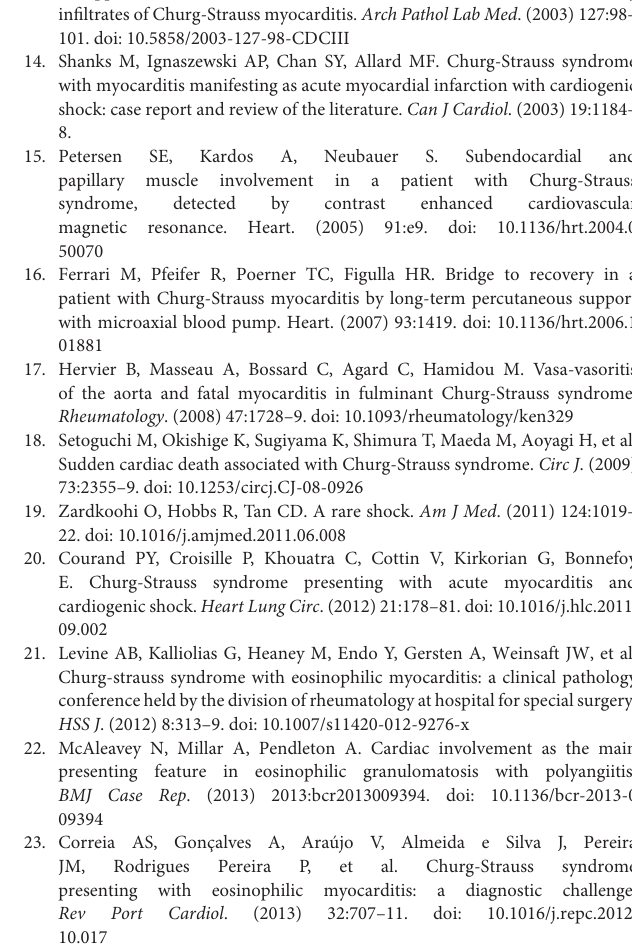
Supplementary Figure 1 | ECG at admission (A) and on day 21 (B) . An initial ECG reveals evidence of pathologic Q waves in V2 to V3, and a significant left axis deviation at − 57 ◦ , which is consistent with a left anterior fascicular block. Notably, the follow-up ECG after treatment of corticosteroid shows the resolution of all abnormal findings recognized during the initial ECG. ECG, electrocardiogram. Supplementary Figure 2 | Clinical effects of the corticosteroid treatment on TTE. Follow-up TTE on day 56 after the corticosteroid therapy reveals a full recovery of the ventricular function and GLS values of the LV (LVDd, 49mm; LVEF, 62%; GLS − 16.1%, respectively) (A–C) . Ao, aorta; GLS, global longitudinal strain; LA, left atrium; LV, left ventricle; LVDd, left ventricular end-diastolic diameter; LVEF, left ventricular ejection fraction; TTE, transthoracic echocardiography. Supplementary Figure 3 | A timeline for the case presentation. EGPA, eosinophilic granulomatosis with polyangiitis; EM, eosinophilic myocarditis; HES,